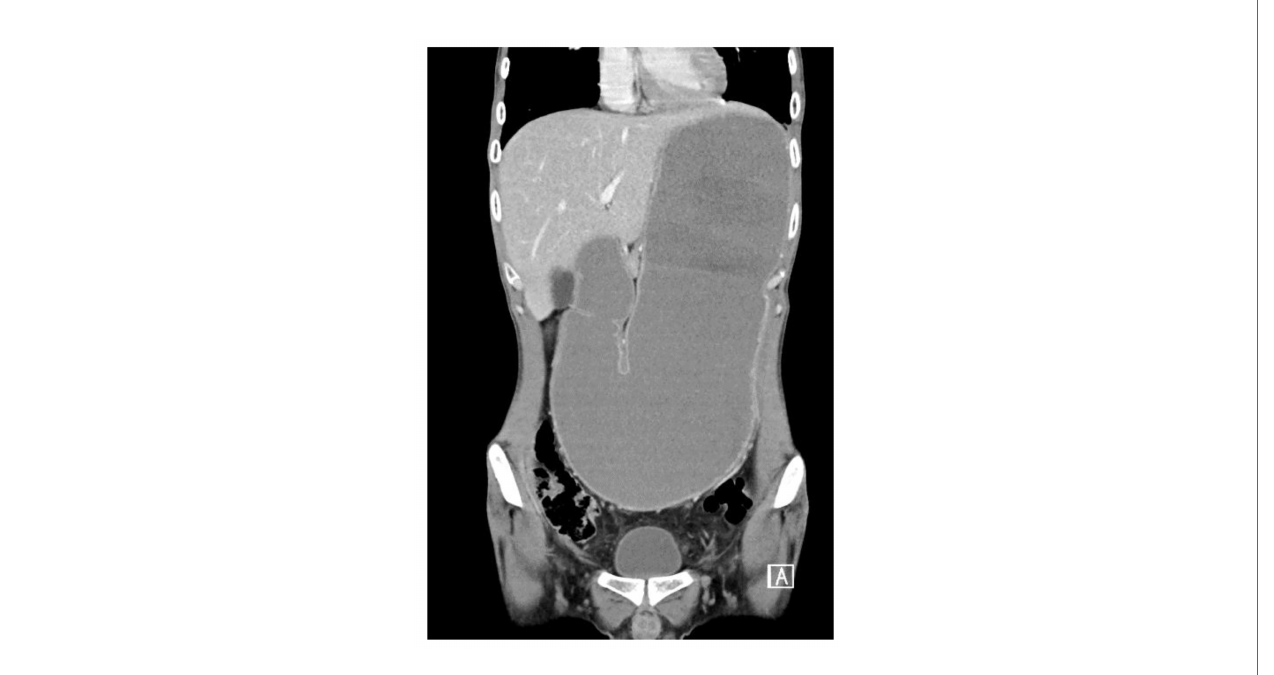
FIGURE 4 | Restaging